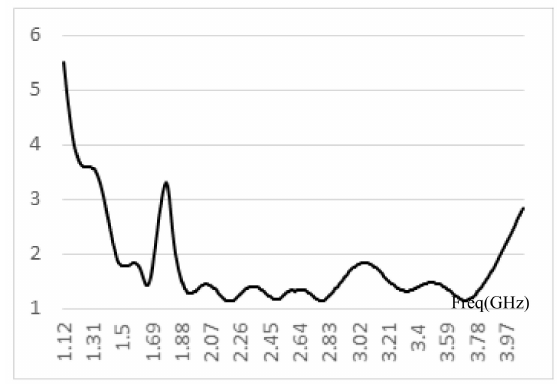
Figure 12. Improved transmitting antenna VSWR.